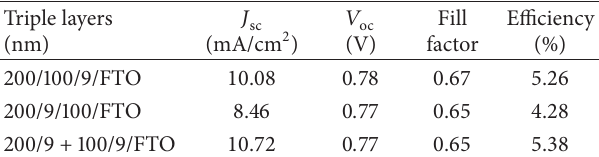
Table 4: Solar performance parameters of DSSCs with triple-layer particle sizes in the first (bottom), sec- structures of different TiO 2 ond (middle), and third (top).